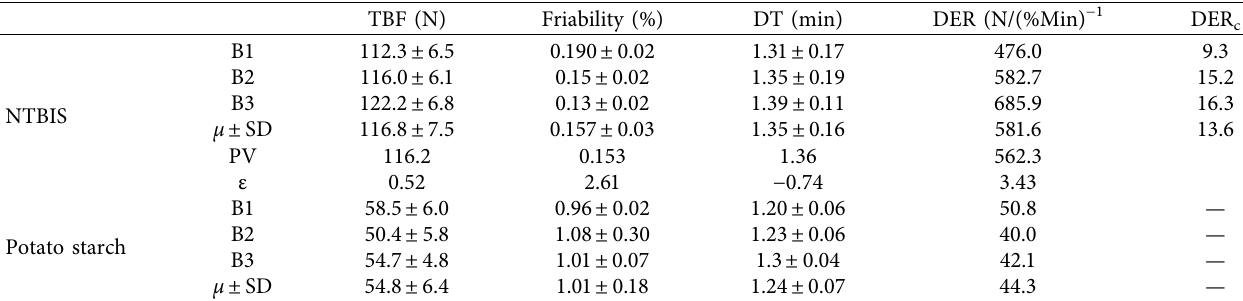
Table 5: The TBF, friability, disintegration time, and DER of tablets prepared with NTBIS and potato starch at optimum levels of